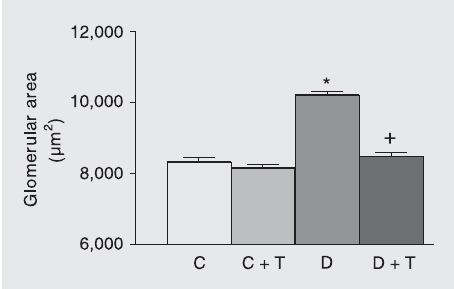
Figure 1. Glomerular area (µm 2 ) for control (C), control plus D- α - tocopherol (C + T), diabetic (D), and diabetic plus D- α -toco- pherol (D + T) groups. Glomeru- lus number/number of histologi- cal fields for each group: C, 373/ 44; C + T, 616/70; D, 729/80; D + T, 505/50. *P < 0.05 vs con- trol; + P < 0.05 vs diabetic ani- mals (ANOVA followed by the Bonferroni